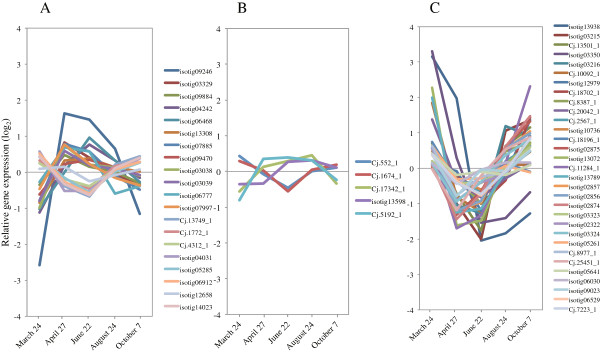
Expression of hormonal regulation-related genes in cambial region during xylem formation. A) Auxin signaling and transport component. B) GA biosynthesis-related and signaling genes. C) ABA biosynthesis-related and signaling genes. The individual targets are summarized in Additional file 3. All expression data are presented on a log2 scale.